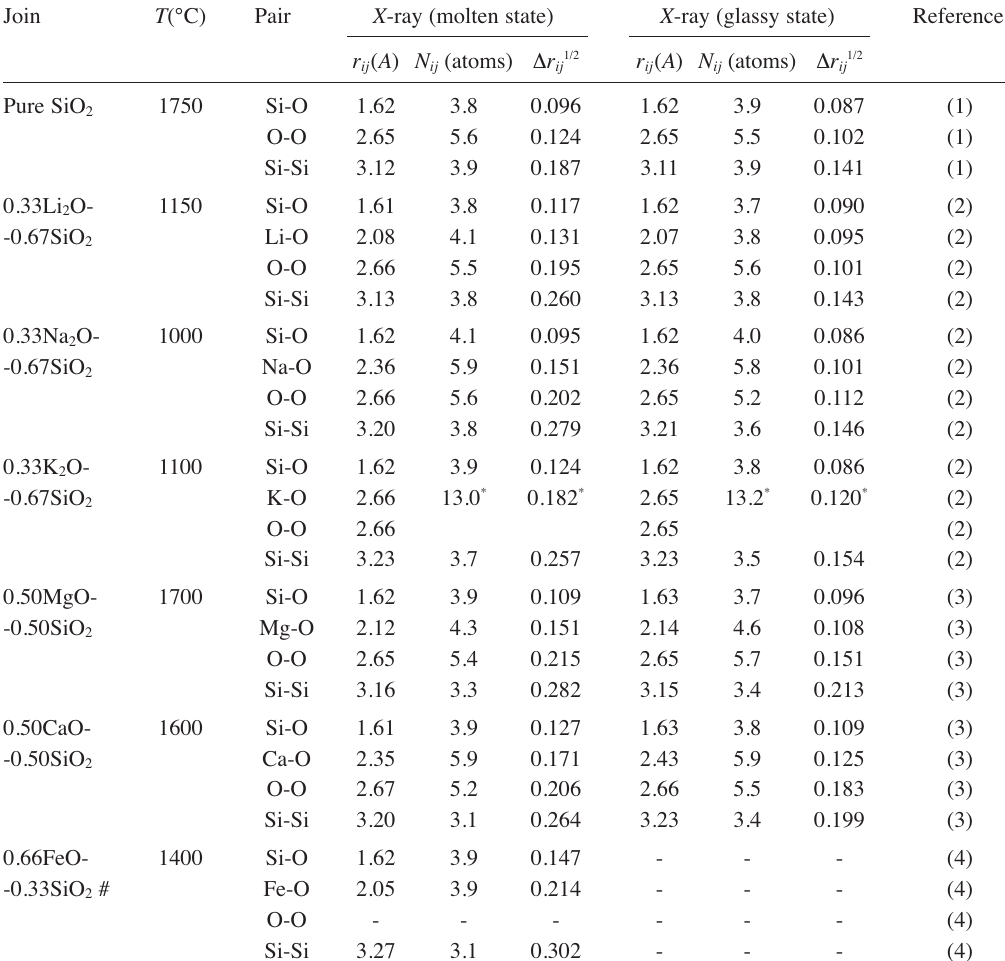
Table I. Structural data for binary silicate melts and glasses (from Brown et al. , 1995). Interionic distance r ij ( A ) approximated to ± 0.01 A ; coordination number N ij approximated to ± 0.3 atoms; root mean square atomic dis- placement ∆ r ij 1/2 approximated to ±